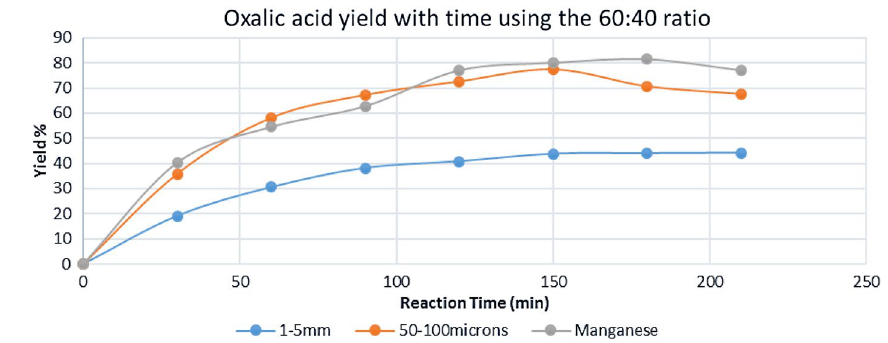
Fig. 7 Effect of reaction time on oxalic acid yield